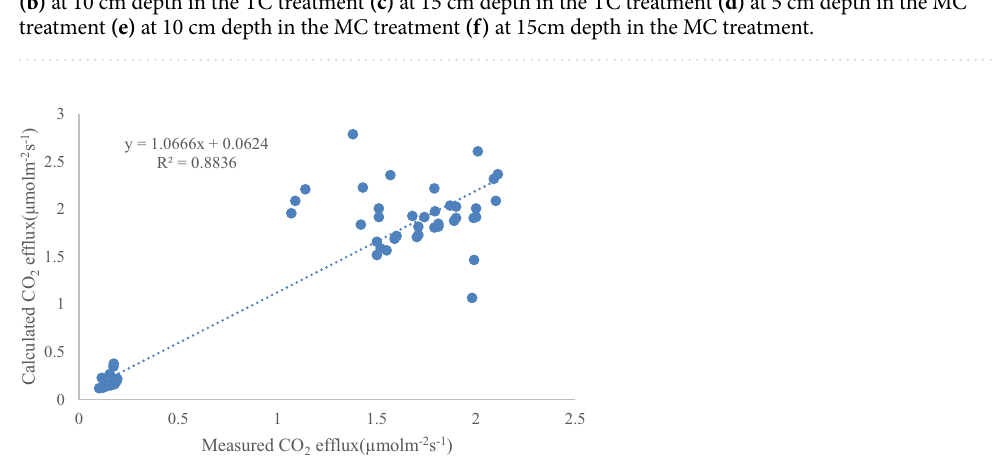
Figure 6. Comparison of calculated and measured CO 2 efflux at soil surface (‘calculated CO 2 efflux’ refer to CO 2 efflux calculated by Fick’s first law of diffusion, and ‘measured CO 2 efflux’ refer to CO 2 efflux measured by chamber